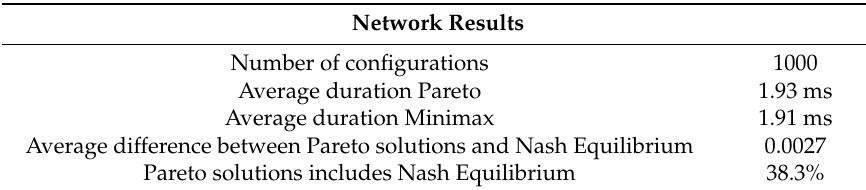
Table 6. Results of Experiment for different configurations.